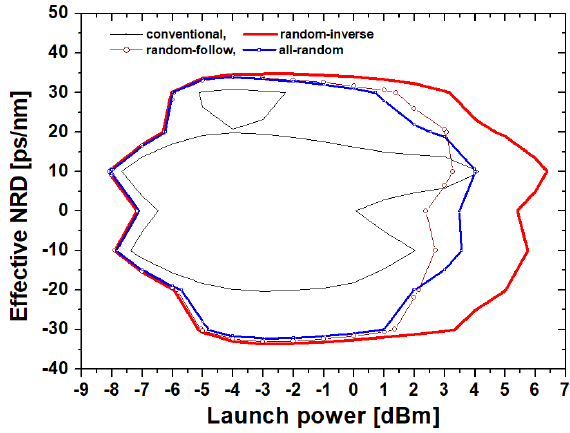
Figure 5. The effective NRD ranges versus the launch power.